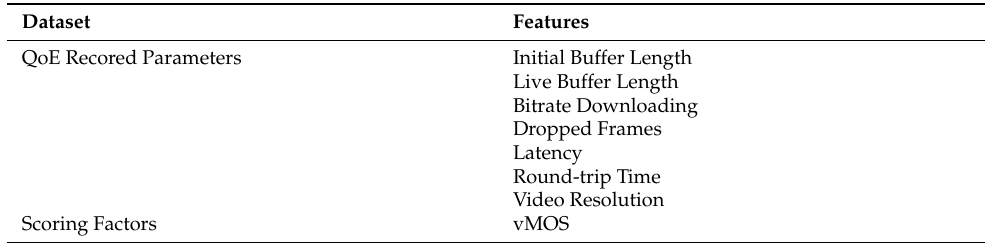
Table 6. Generated dataset.